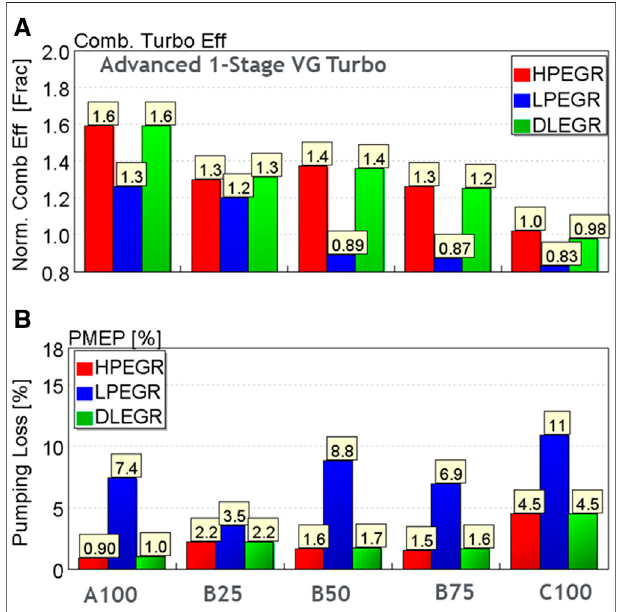
FIGURE 11 | (A) Normalized combined turbo ef fi ciencies and (B) PMEP % comparisons for advanced 1-Stage VG Turbocharger using various EGR con fi